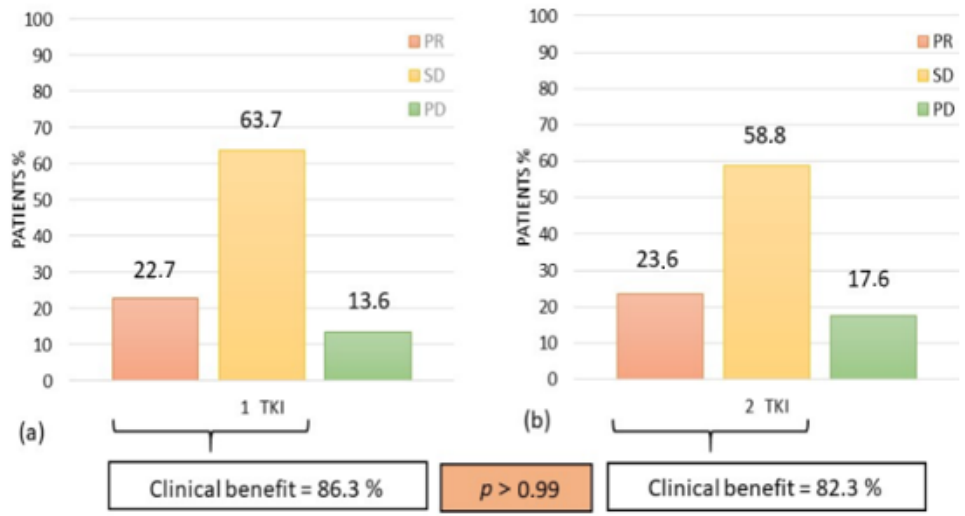
Figure 1. Best overall response and clinical benefit in the Study group: ( a ) with the first TKI ( b ) with the second TKI. PR: partial response; SD: stable disease; PD: progressive disease.